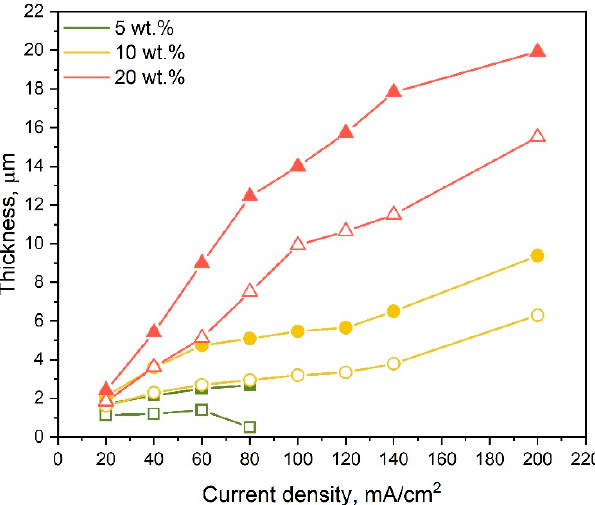
Figure 4. The PS thickness dependence on applied current density during electrochemical ano- dization in different concentration HF solutions. Initial PS samples are marked with filled symbols, RIE-treated samples with unfilled symbols.